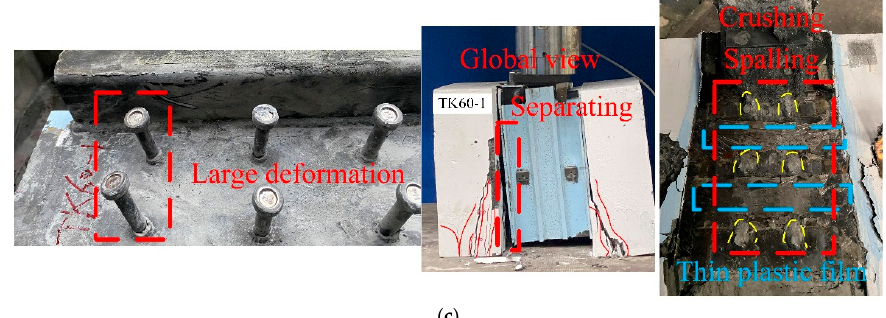
Figure 12. Failure state of specimens:( a ) Failure form of specimens of ZC group; ( b ) Failure form of specimens of TK30 group; ( c ) Failure form of specimens of TK60 group.